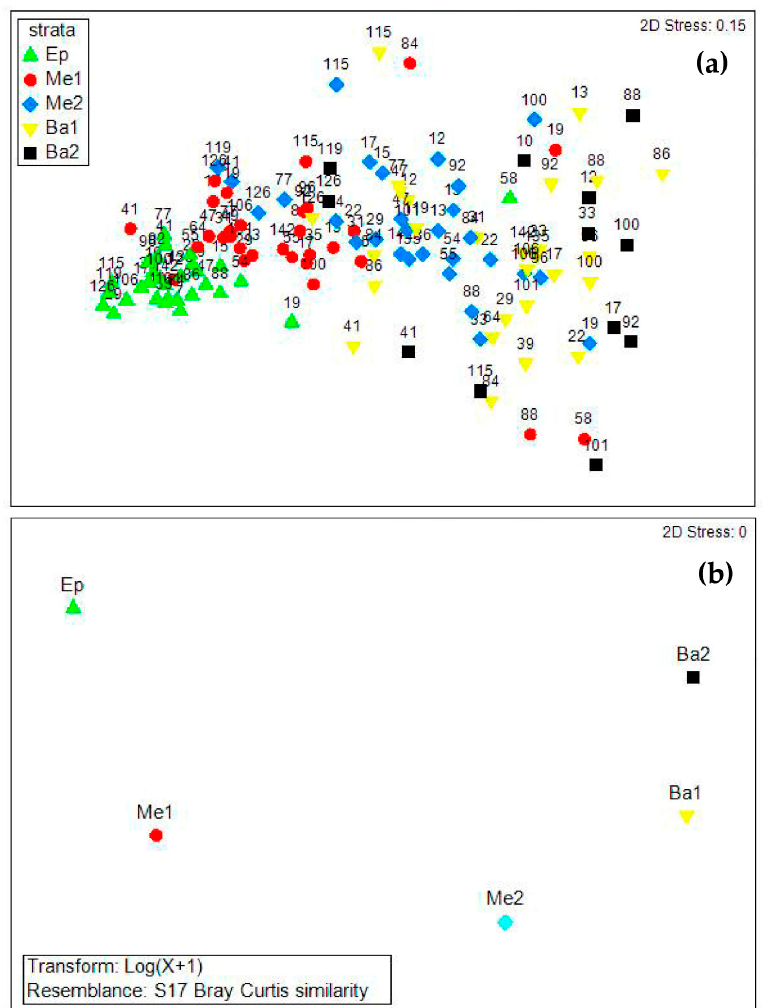
Figure 5. NMDS Ordination analysis of zooplankton community found at the stations and depth layers (Epipelagic: Ep; Upper and lower Mesopelagic: Me1 and Me2; Upper and Lower Bathypelagic: Ba1 and Ba2) regarding ( a ) the abundance of copepods (ind.m − 3 ) at each sampled stations, and ( b ) average abundance of copepods at each depth layer.